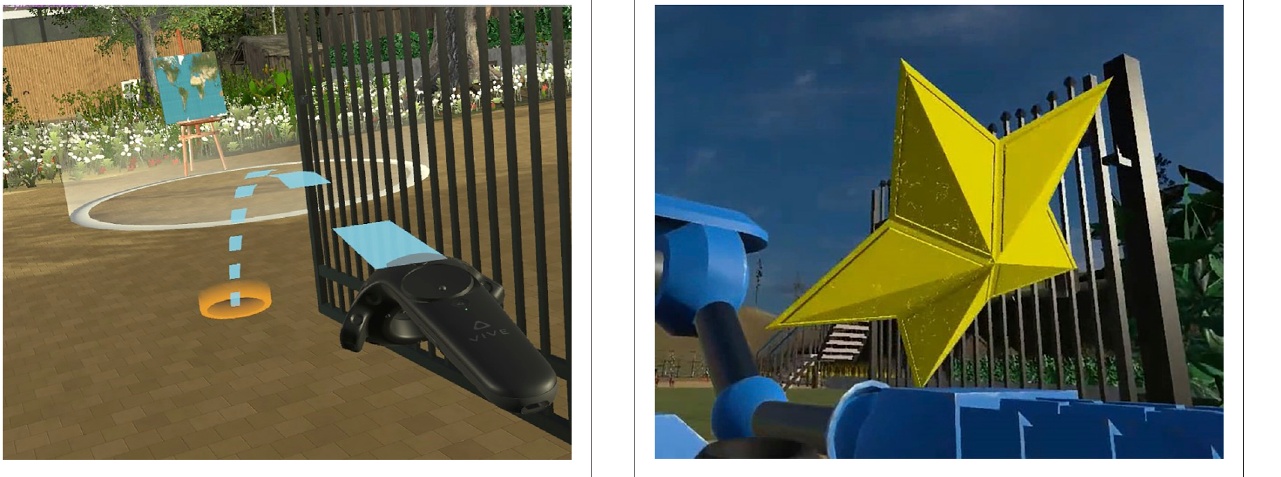
FIGURE 2 | Usage of the hand-held controller to teleport. FIGURE 3 | Example of the stars collectable as rewards during the